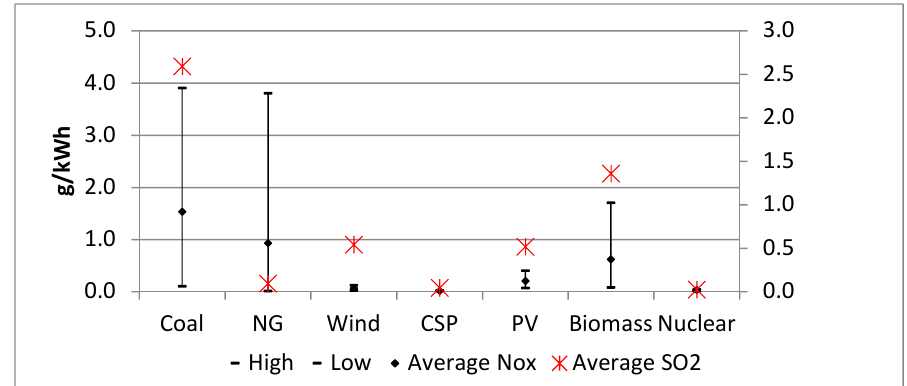
Figure 6. NO x and SO 2 emissions from the technologies under assessment [40,43,45,63–66].